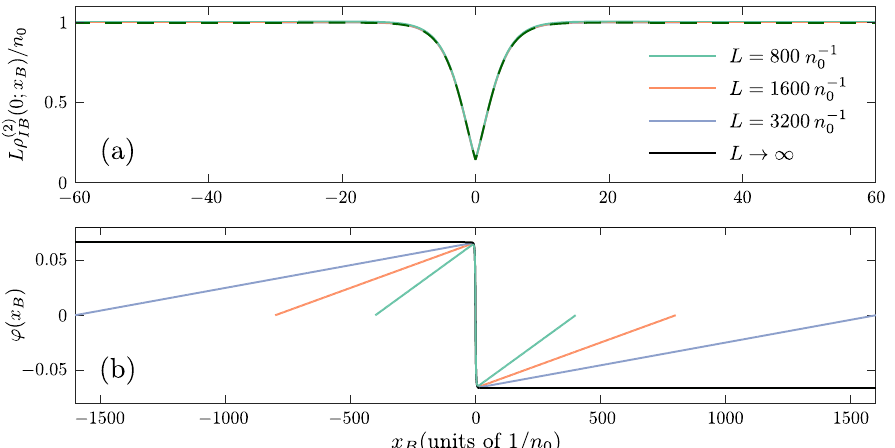
Figure A1. Convergence of the GA Bose polaron solution to the N , L → ∞ limit. ( a ) Bath-impurity correlation function, ρ but different ring lengths L (see legend). In order to keep n 0 = 1 in our calculations, we demand N B = n 0 L , while the spatial region | x B | > 60 n − 1 ( b ) The phase profile, φ ( x B ) = arg ( ψ ( x B )) , of the solutions for the above mentioned parameters and for the same varying values of L